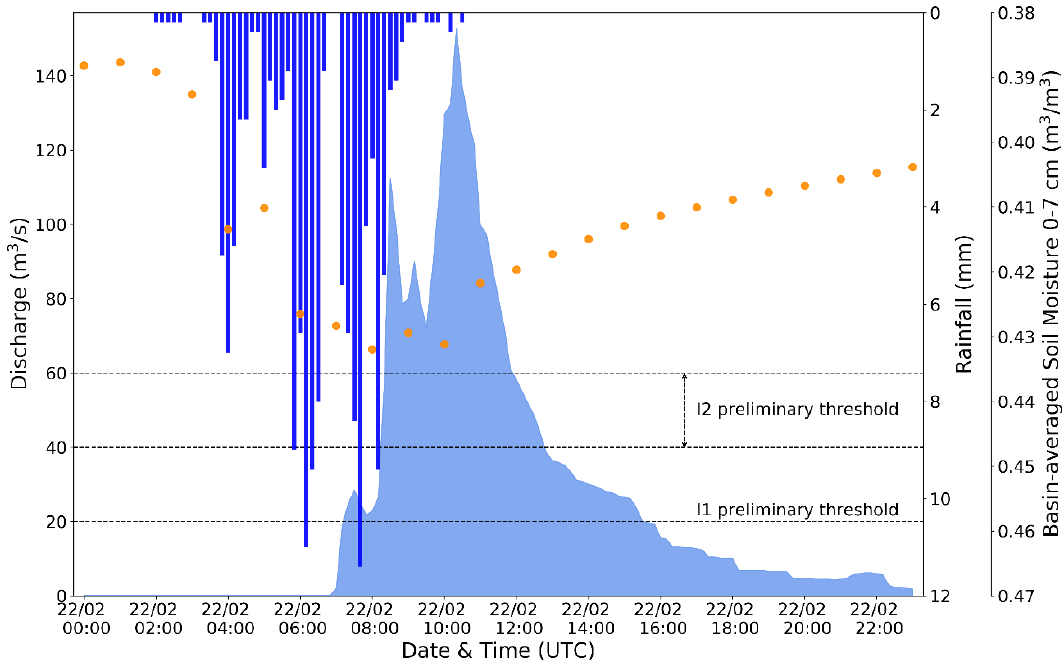
Figure 11. Time series of 10-min precipitation (blue bars; mm) and stream discharge (light blue filled areas; m 3 /s) over Ayios Nikolaos meteorological station and Rafina hydrological station, respectively, and of 1-h basin-averaged volumetric (0–7 cm) soil water content (orange dots; m 3 /m 3 ) from 10 December 2009, 1900 UTC, to 11 December 2009, 1800 UTC.